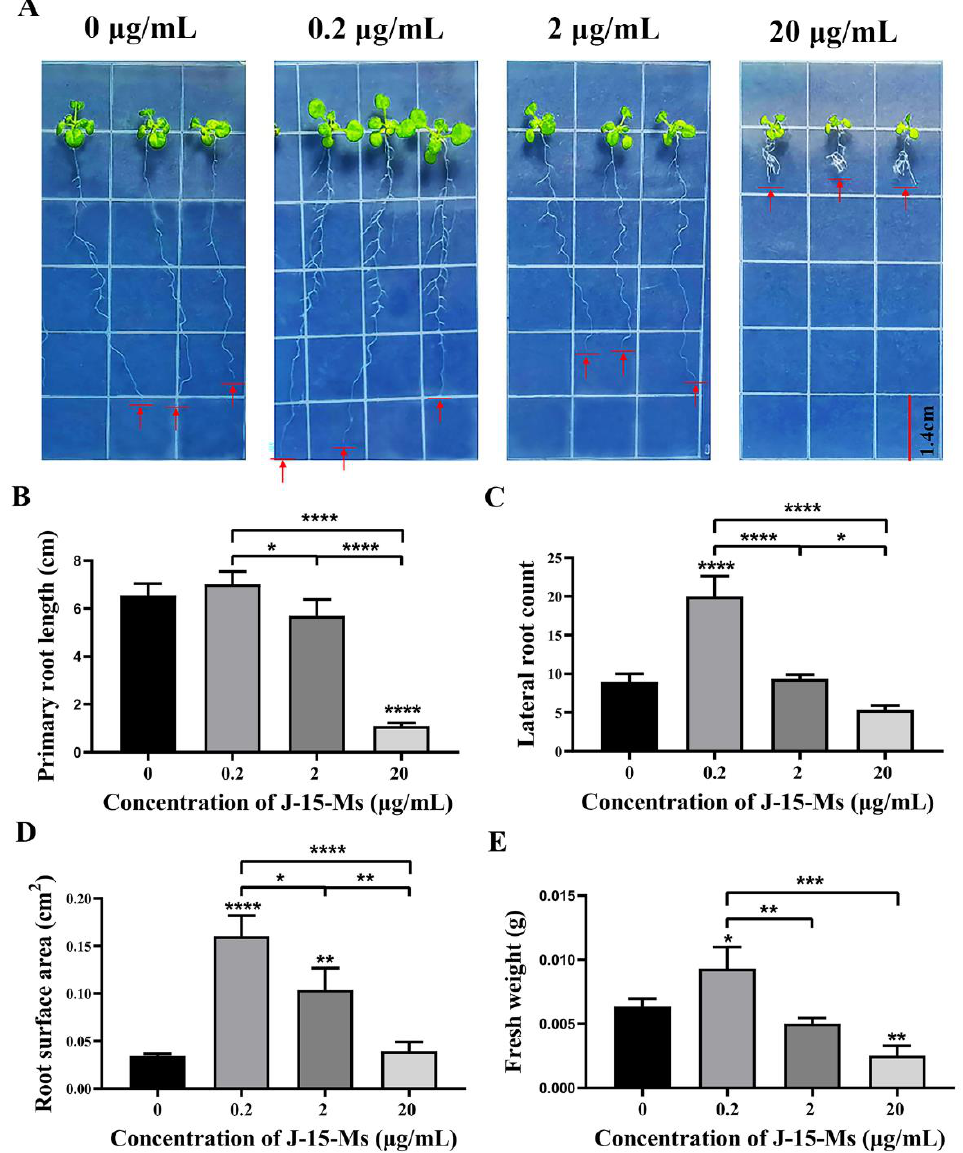
Figure 1. Effect of J-15-Ms on the growth of Arabidopsis seedlings. ( A ) Arabidopsis seedling growth phenotype. ( B ) Effect on primary root length. ( C ) Effect on lateral root number. ( D ) Effect on root surface area. ( E ) Effect on fresh weight. Schemes follow the same formatting. Note: Means ± SEs, n = 50, different “*” indicate significant differences among treatments based on the least significant difference at p ≤ 0.05.